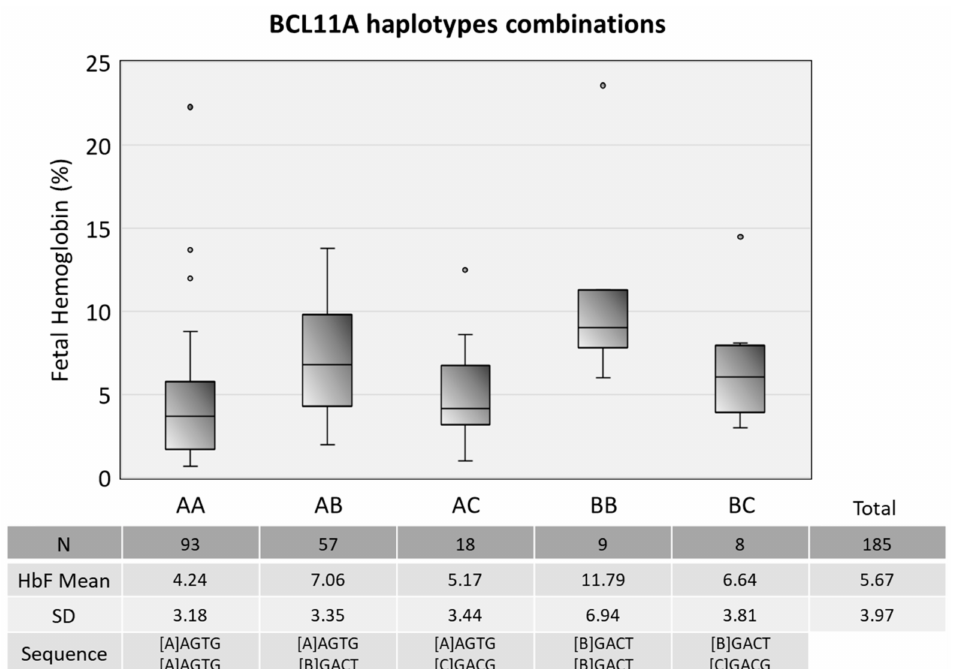
Figure 4. Distribution of HbF levels in different combinations of haplotypes made with four SNPs in BCL11A gene in the following order: rs7557939, rs4671393, rs11886868 and rs1427407. The Arlequin software defined ten different combinations using these four polymorphisms from the study’s cohort. Due to the low frequency of some combinations, this table only includes the five most prevalent. Lines of the boxes represent the lower quartile, median, and upper quartile, and the outliers are the points outside the whiskers. Statistical analysis showed a significant difference of the mean HbF value within the five groups ( p -value < 0.001) by the one-way